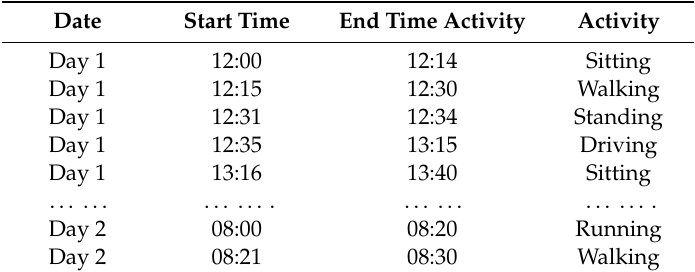
Table 2. Dataset: examples of activities.